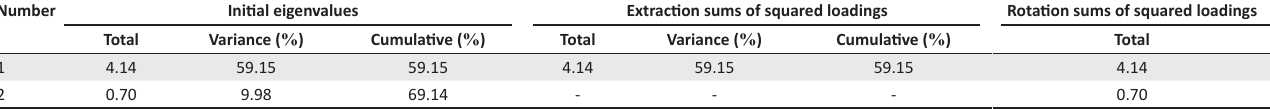
TABLE 2: Eigenvalues close to or larger than one and explanation of variance. Number Initial eigenvalues Extraction sums of squared loadings Rotation sums of squared